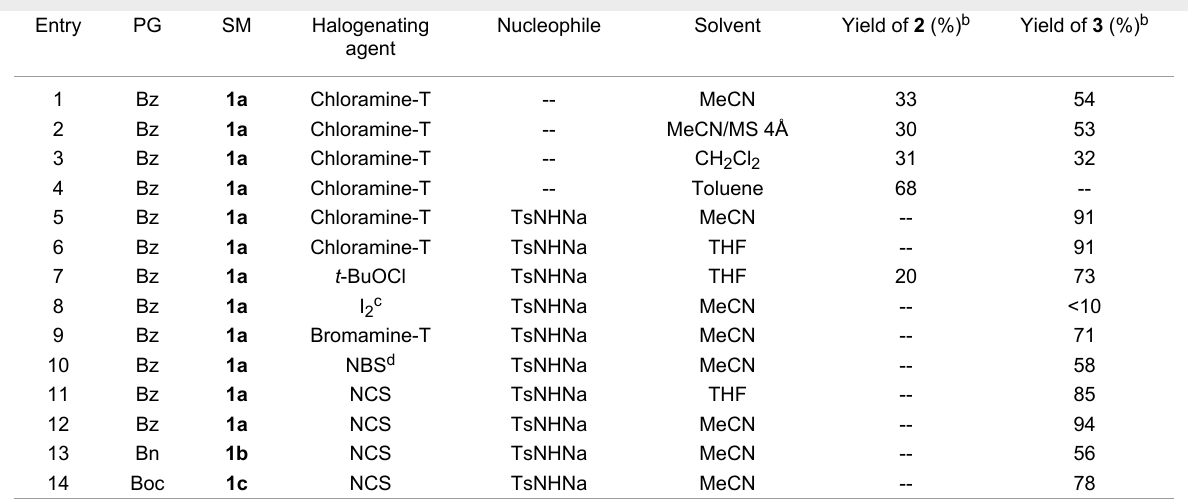
Table 1: Halogenating agent effect on the synthesis of sulfonimidamides 3